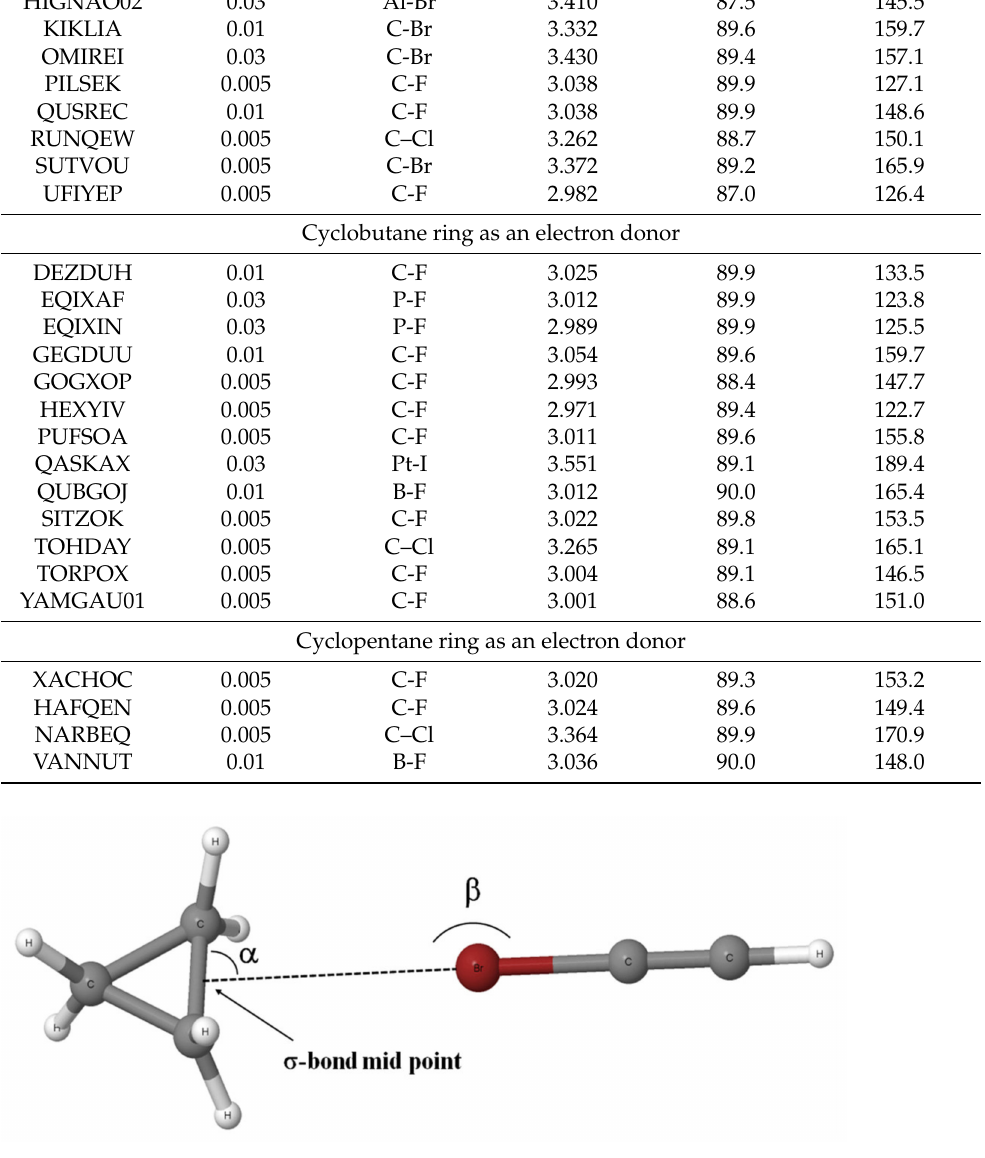
Scheme 3. The definition α and β angles: the example of the C 3 H 6 ··· BrCCH complex. The first search on complexes of dihydrogen led to the finding of four structures. Three cases concern different refinements of the same crystal structure, ( η 5 -pentamethyl- cyclopentadienyl)-(dihydrogen)-dihydrido- triphenylphosphine—osmium (iv) tetrafluo- roborate (NOLJIH, NOLJIH01 and NOLJIH02 refcodes). The fourth case is the